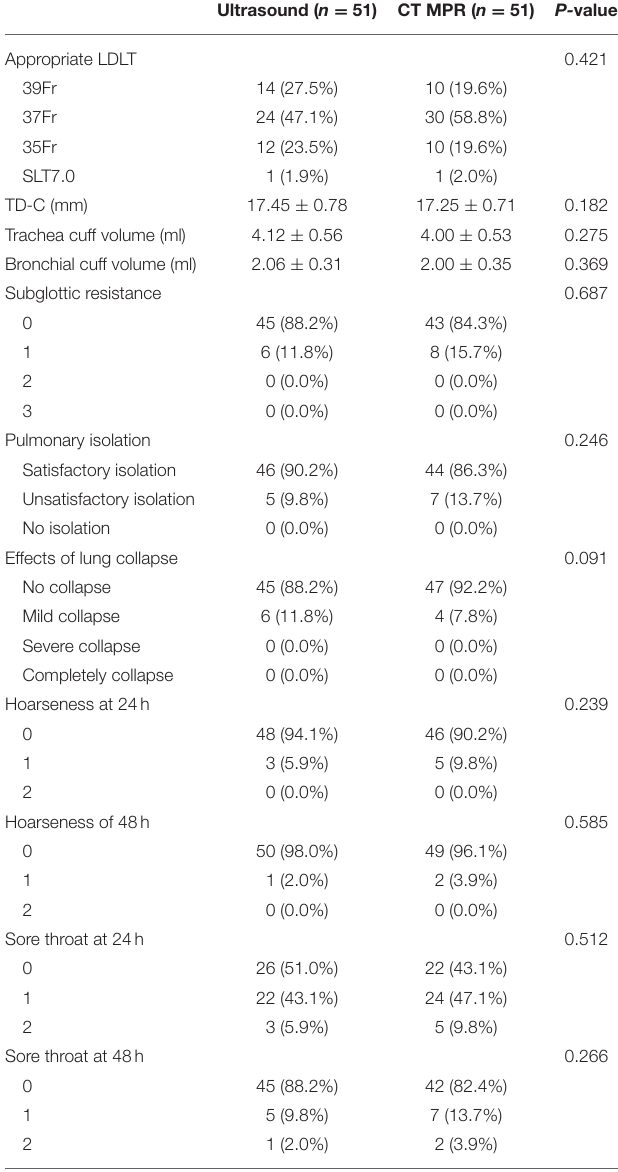
TABLE 6 | Comparison of observation indexes among the two